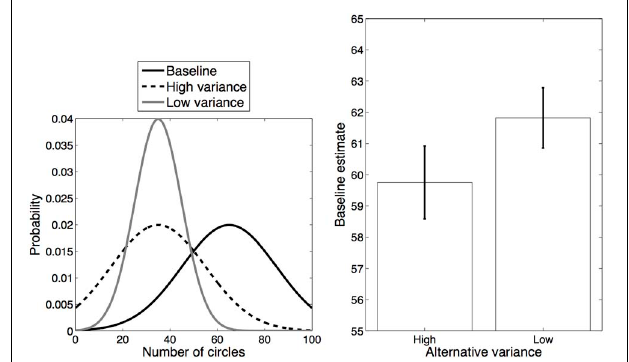
FIGURE 4 | Experiment 2 design and results. Left : Distributions for each category. Right : Average estimates for the baseline category in each condition. Error bars represent standard error of the